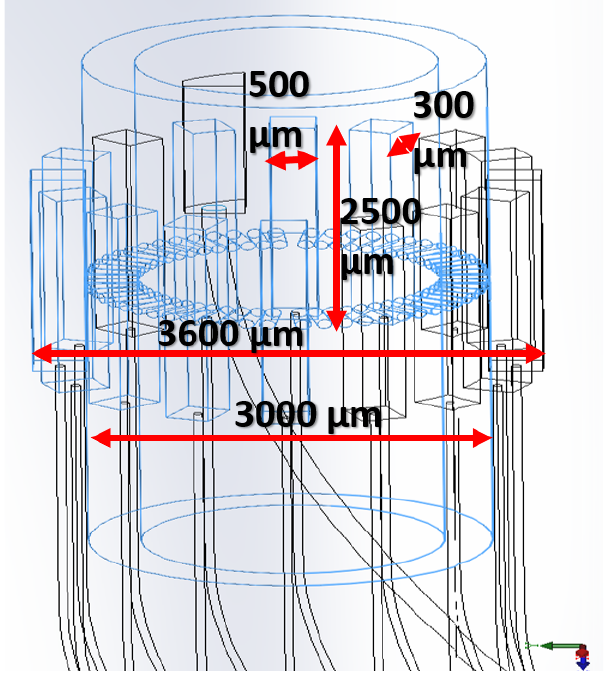
Figure 5. Geometry of MEMS-transducer array, 16 pcs lead zirconate titanate (PZT) arranged in a ring to form a tube.